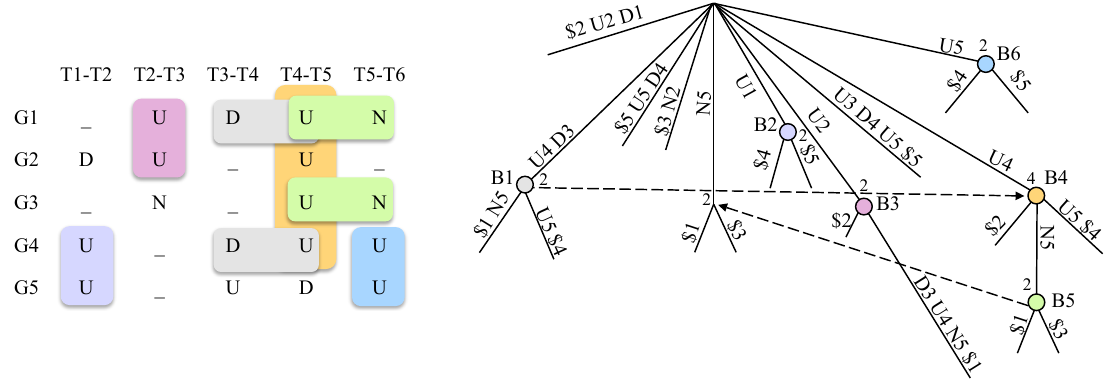
Figure 2: Maximal CCC-Biclusters in the discretized matrix and related nodes in the suffix